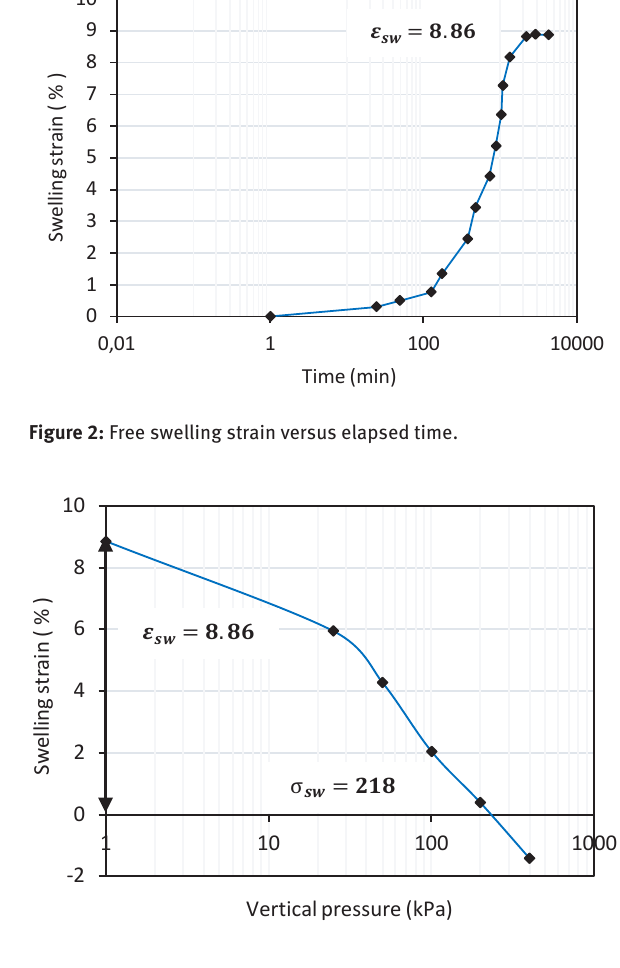
Figure 4: Scheme of stresses distributions in the soil below a shallow foundation